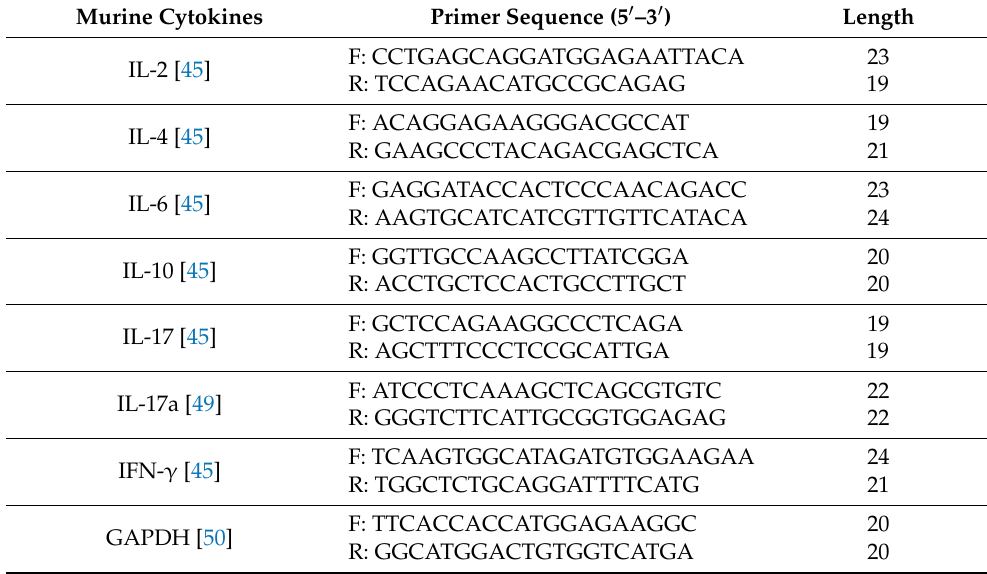
Table 3. Primer sequence of the target genes of murine oral squamous cell carcinoma tissues. Murine